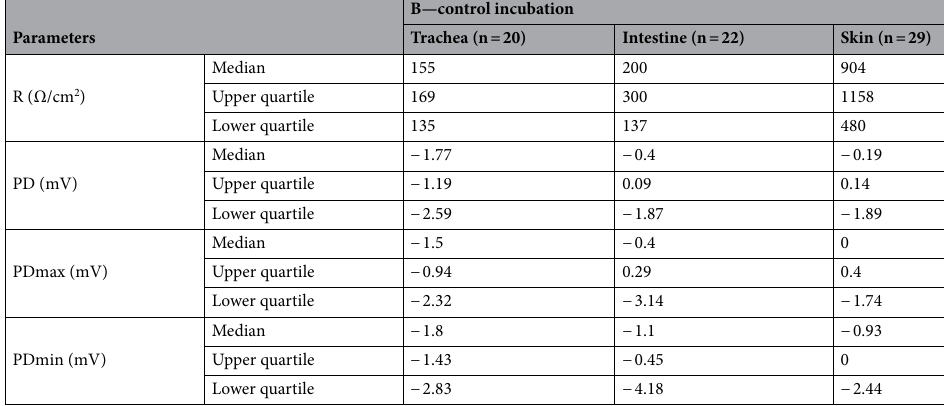
Table 1. The electrophysiological parameters measured during 15-s mechanical-chemical stimulations by bumetanide (0.1 mM) of the trachea, intestine and skin specimens. The values of medians and lower and upper quartiles are given. Abbreviations: B—the specimens incubated in the bumetanide (B, 0.1 mM) solution, PD—transepithelial potential difference of tissues surface (mV) measured in stationary conditions, PDmin— minimal transepithelial potential difference measured during a 15 s stimulation of the tissue surface (mV), PDmax—maximal transepithelial potential difference measured during a 15 s stimulation of the tissue surface (mV), R—resistance (Ω/cm 2 ), p < 0.05.